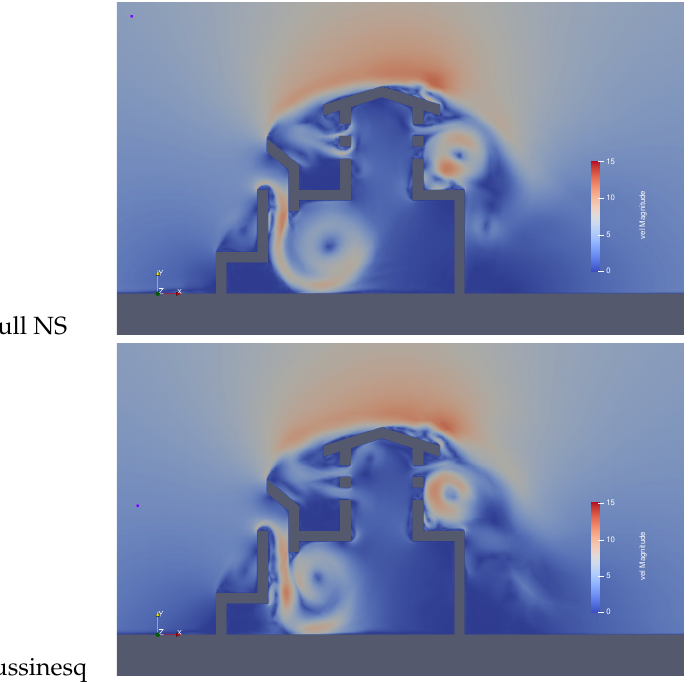
Figure 17. Wind tower 1. Velocity modulus obtained using the full NS and the Boussinesq model and U ∞ = 5